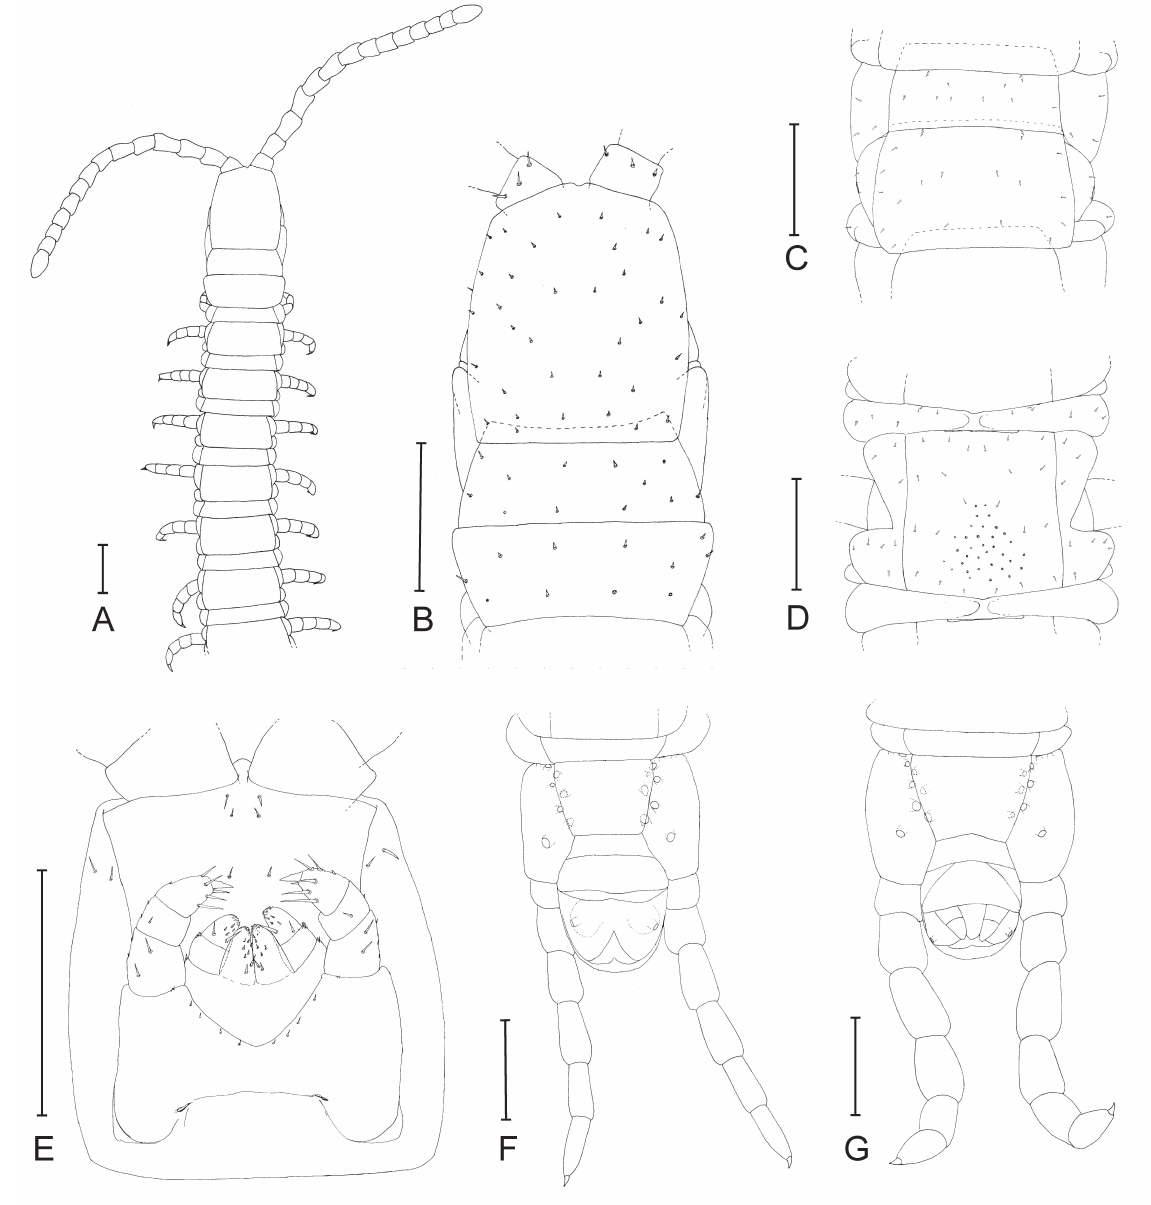
Fig. 1. Endogeophilus ichnusae gen. et sp. nov. A–F . Holotype, ♀. A . Anterior part of the body, dorsal view, setae omitted. B . Head, without antennae, and forcipular segment, dorsal view. C . Leg-bearing segment 21, dorsal view. D . Leg-bearing segment 21, ventral view. E . Head, without antennae, ventral view. F . Ultimate leg-bearing segment and postpedal segments, ventral view, setae omitted. G . Paratype B, ♂, ultimate leg-bearing segment and postpedal segments, ventral view, setae omitted. Line drawings based on photos taken at the microscope. Scale bars = 200